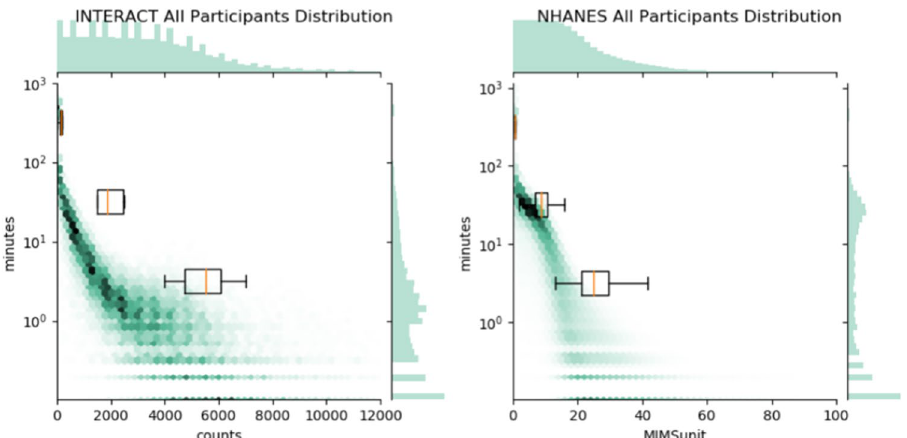
Figure 2. The distributions of all participants for the NHANES and INTERACT studies. The boxplots in each figure represent the distributions of each breakpoint, with the orange line representing the median, the box illustrating the upper and lower quartiles of each breakpoint, and the whiskers indicating the range of